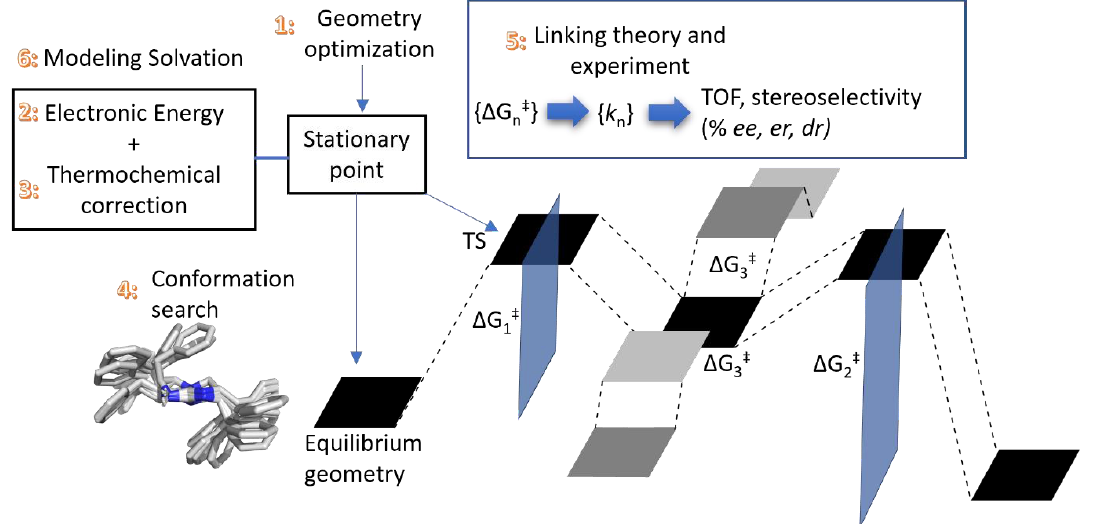
Figure 1. Summary of this review. Workflow to calculate a reaction performance metric from key stationary points on the potential energy surface. Numbers in orange corresponds to the sequence in which the mentioned topics will appear in this review.